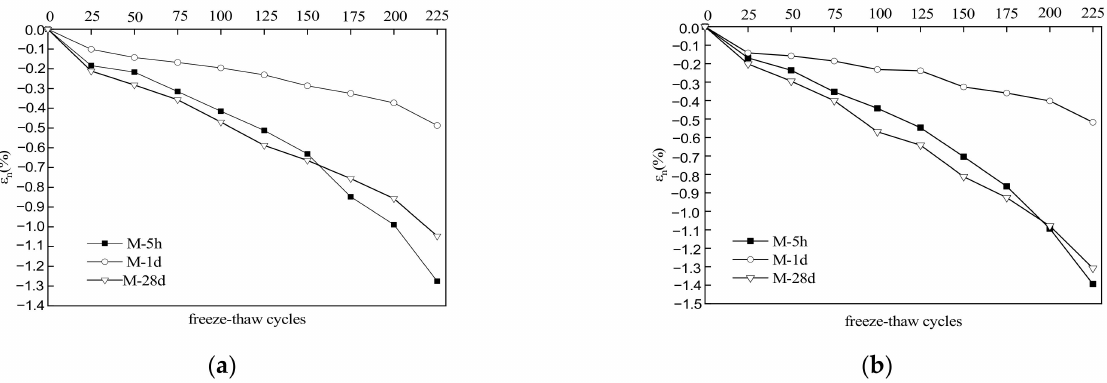
Figure 5. Trends of volume deformation of MKPC mortar specimens with number of freeze–thaw cycles. ( a ) Freezing and thawing in water. ( b ) Freezing and thawing in 5% Na 2 SO 4